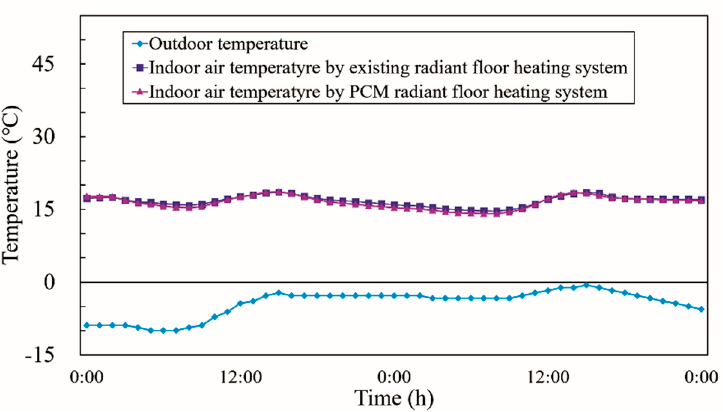
Figure 9. Indoor air temperatures on the second stories of the apartment buildings.